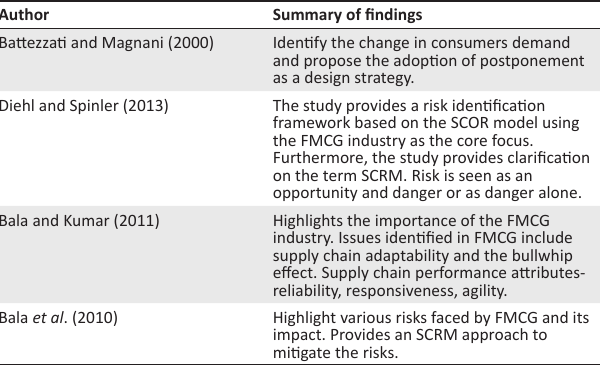
TABLE 2: Summary of applicable literature on the fast-moving consumer goods